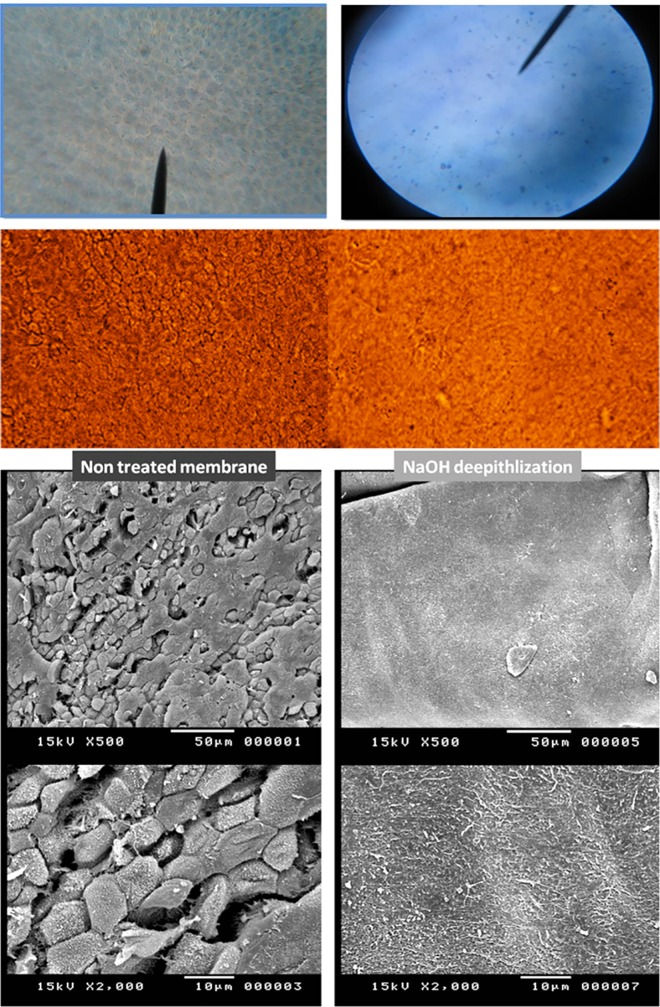
Human Amniotic Membrane Surface Treatment.This figure shows the fetal side of the hAM in its intact (left column) and decellularized (right column) states. Complete decellularization was achieved in repeat experiments using the brief alkaline method as demonstrated by various imaging modalities and magnifications (Top lane shows bright field microscopy images where hAM stained with methylene blue, second lane shows inverted microscopy images followed by SEM images at x500 and x2000).